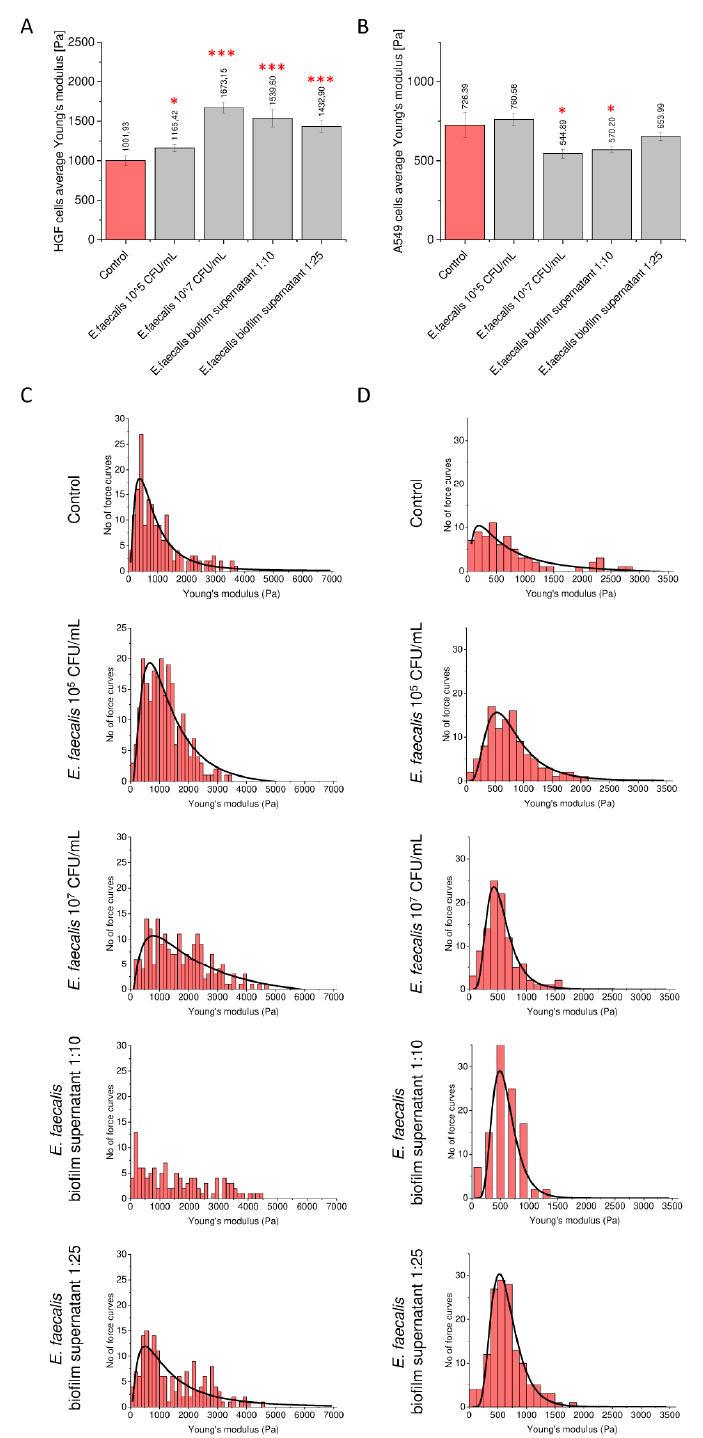
Figure 6. Changes in nanomechanical properties of gingival and lung cancer cells upon stimulation with E. faecalis ATCC 29212 determined by AFM using an indentation depth value of 300 nm. Summary of Young’s modulus analysis for HGF (panel A ) and A549 cells (panel B ) treated with heat-inactivated E. faecalis ATCC 29212 in concentrations of 10 5 and 10 7 CFU / mL or biofilm-derived supernatant diluted 10- or 25-fold. Histograms representing the distribution of force curves obtained from tested cells (panels C , D ). Results are presented as mean ± SE. * and *** indicate statistical significance ( p value < 0.05 and 0.0001, respectively) when compared to unstimulated control cells. By contrast, stimulation of lung carcinoma A549 cells with E. faecalis products directs cells toward having much softer features, resulting in a decrease in the average Young’s modulus from 726.39 ± 78.51 Pa for control cells to 544.88 ± 28.45 Pa for E. faecalis -treated cells and 570.19 ± 21.01 Pa in the case of A549 cells stimulated with 10-fold diluted solution collected from bacterial biofilm (Figure 6C,D). The above results indicate that root canal-occurring bacteria significantly affect the